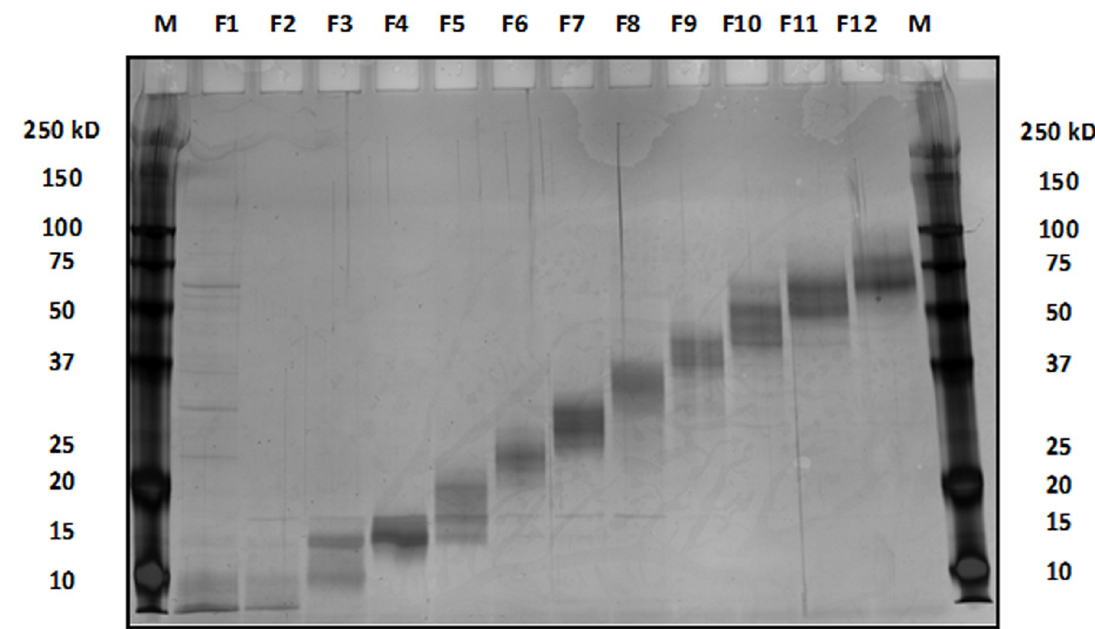
Fig 1. GELFREE protein fraction bands of tissue sample separated by 12%